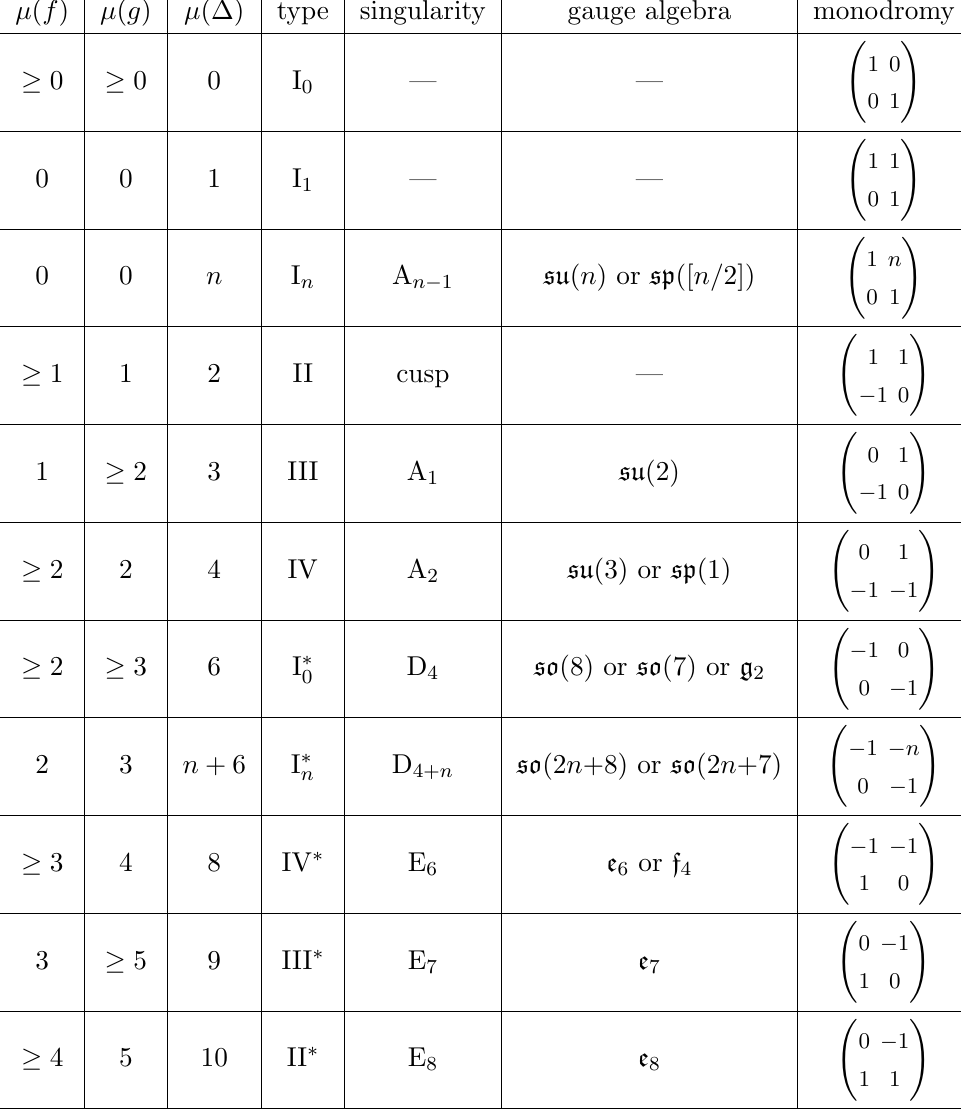
in table 1. The gauge algebra supported on each divisor is uniquely identi(cid:12)ed analyzing the monodromy covers